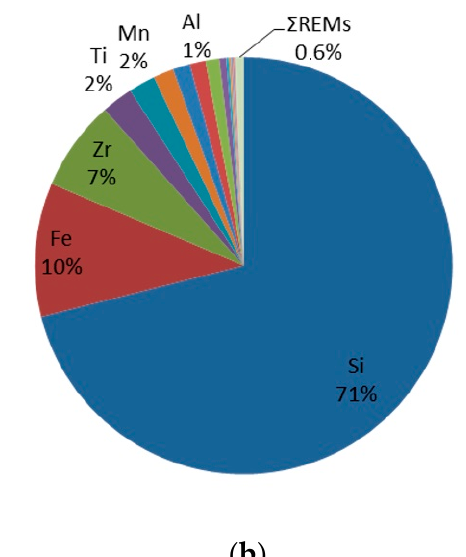
Figure 4. Distribution of element fractions before ( a ) and after ( b ) the eudialyte ore concentrate breakdown.